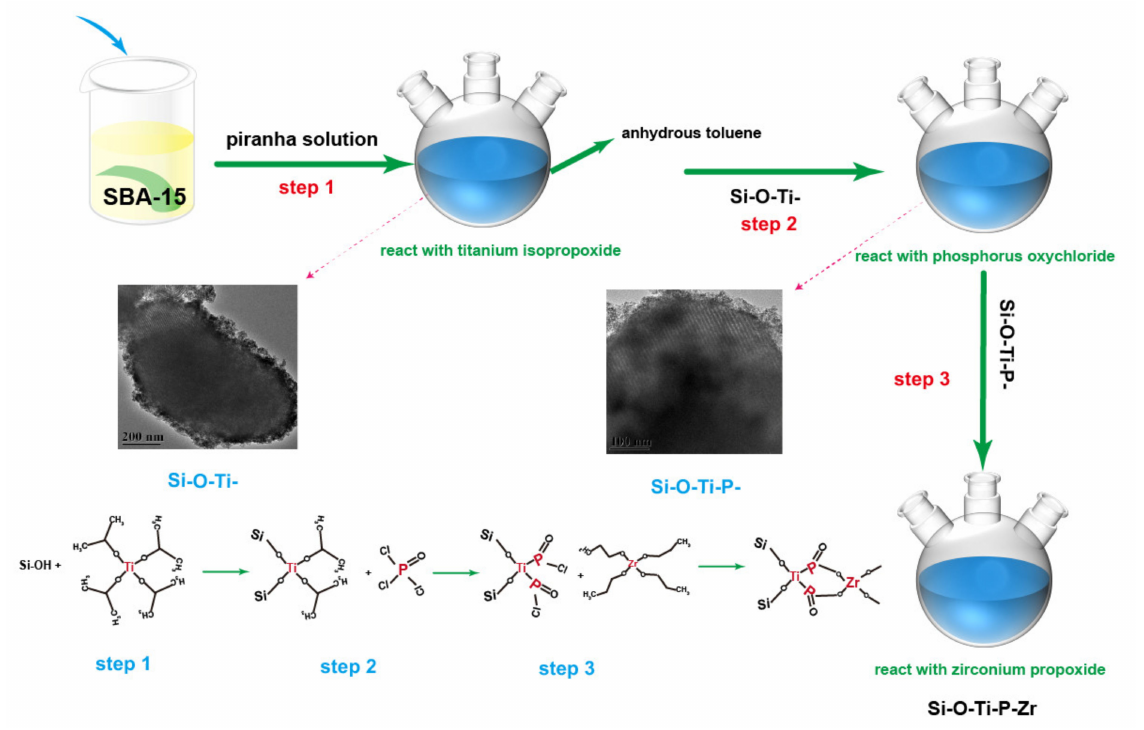
Figure 1. Synthesis process of the